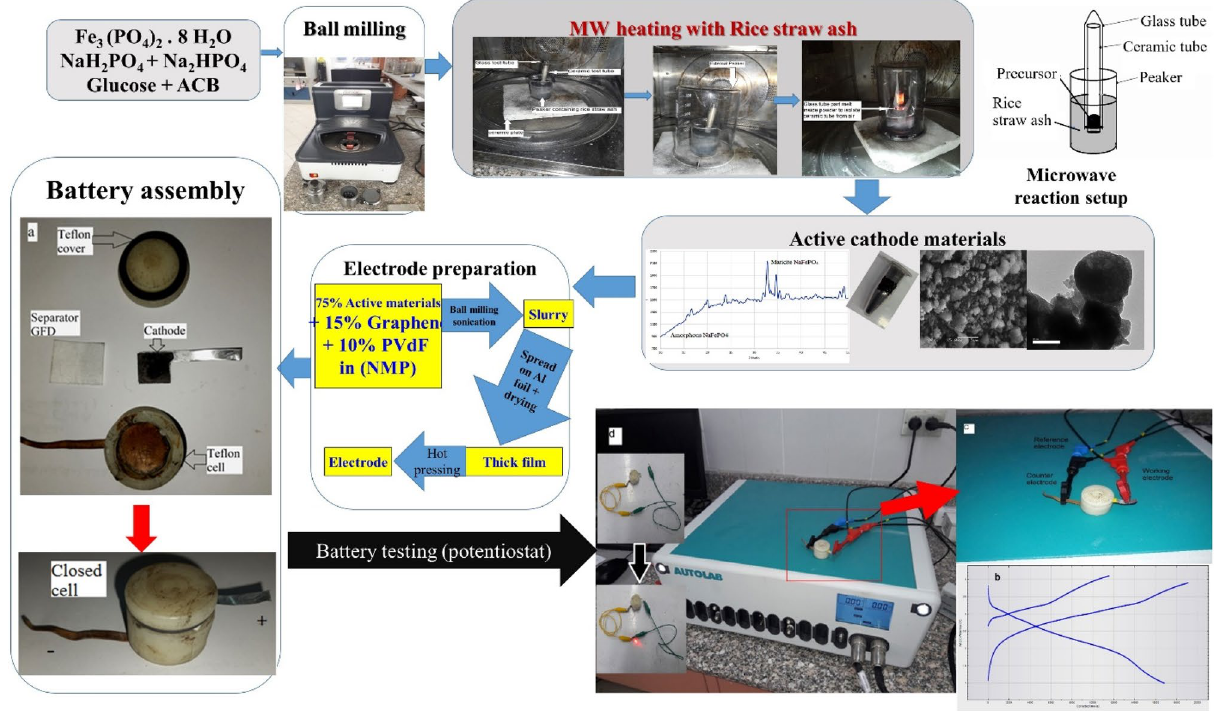
Figure 1. Synthesis process of sodium iron phosphate through ball milling and microwave assisted and assembly of related batteries and